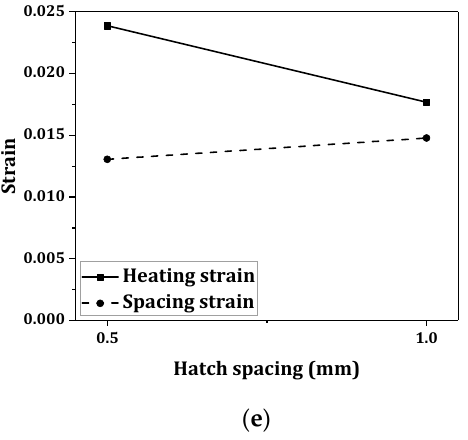
Figure 5. Heating and spacing strains at D b of ( a ) 0.25; ( b ) 0.5; ( c ) 0.7; ( d ) 1.0; and ( e ) 1.3 mm.